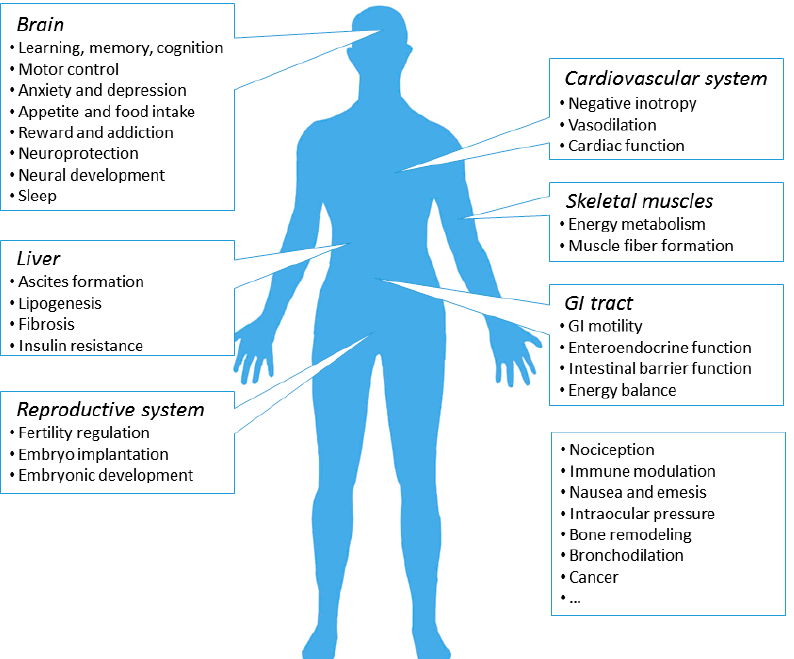
Figure 2. Major localization sites and associated functions of the CB1R in the human body. The majority of CB1Rs expressed in human body is found in the brain, where it is involved in various neurological activities. CB1Rs on the peripheral sites, although to a lesser extent, participates in the regulation of local tissue functions.